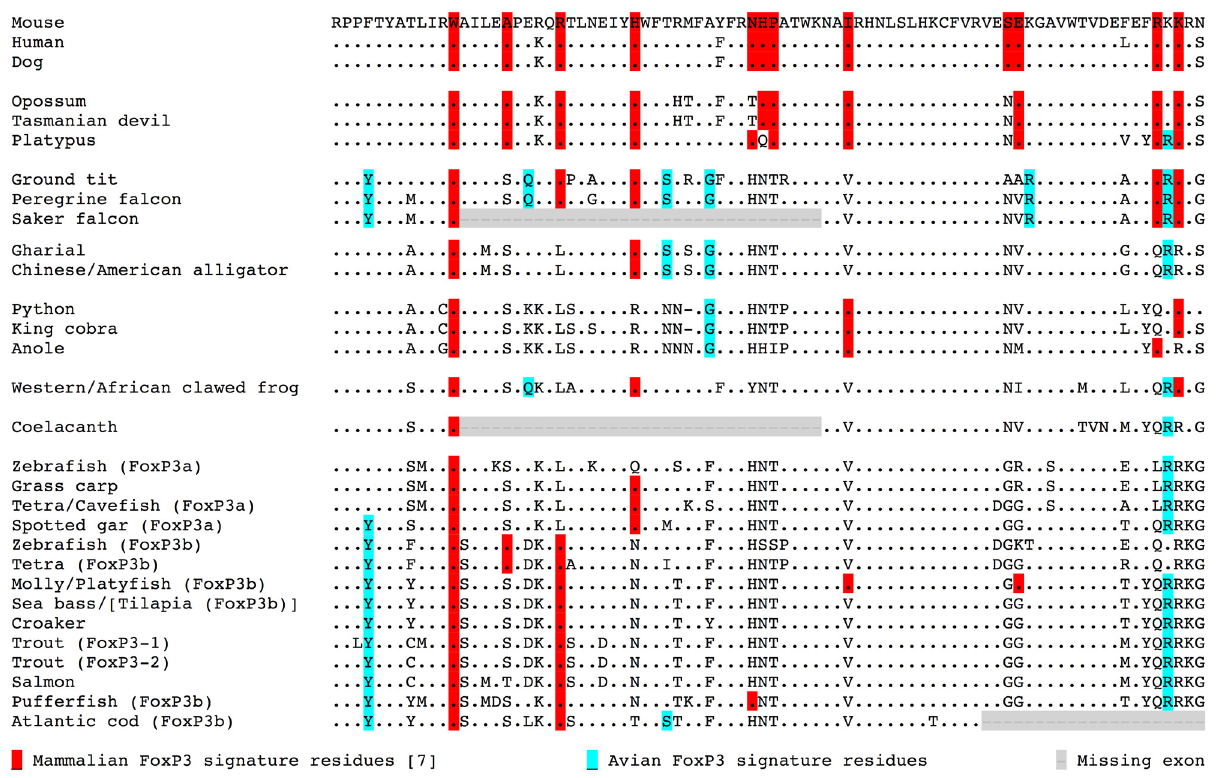
Fig 4. Alignment of the forkhead domain of FoxP3 and FoxP3-like proteins, highlighting mammalian and avian signature residues. The consistent exon boundaries in the ground tit and peregrine falcon were used to curate the gap within the sequence of the saker falcon. The mouse sequence is used as the baseline sequence and only amino acids in other sequences that differ are shown.